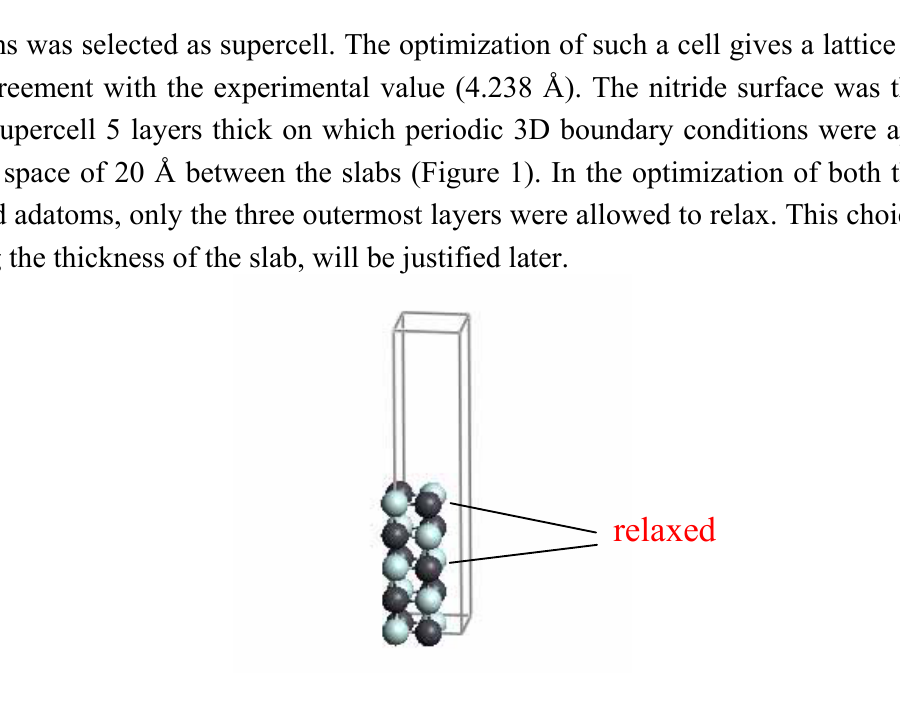
Figure 1. View of the 2 x 2 cell five layer thick used to represent the TiN (001) surface.